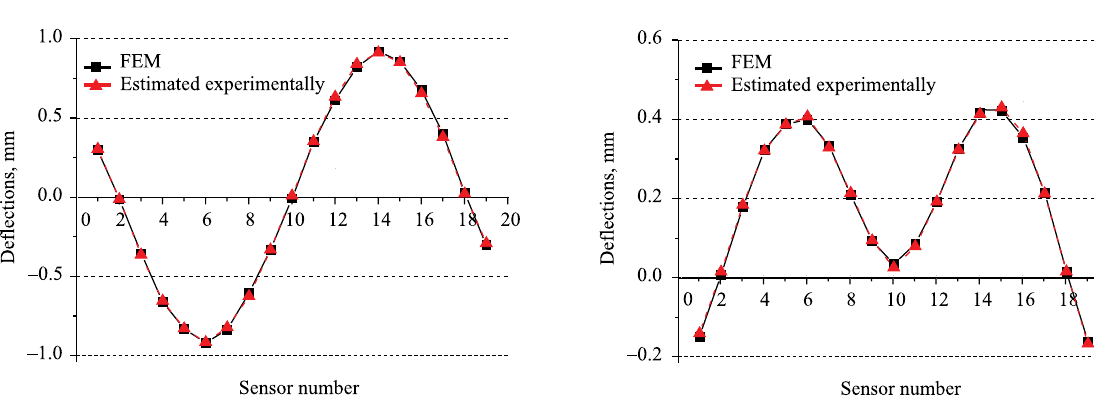
Comparison of deflections under f 1